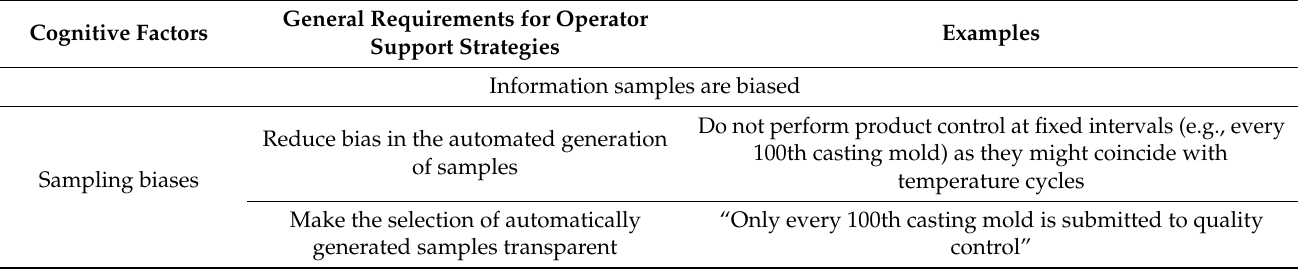
Table A1. Sampling the available